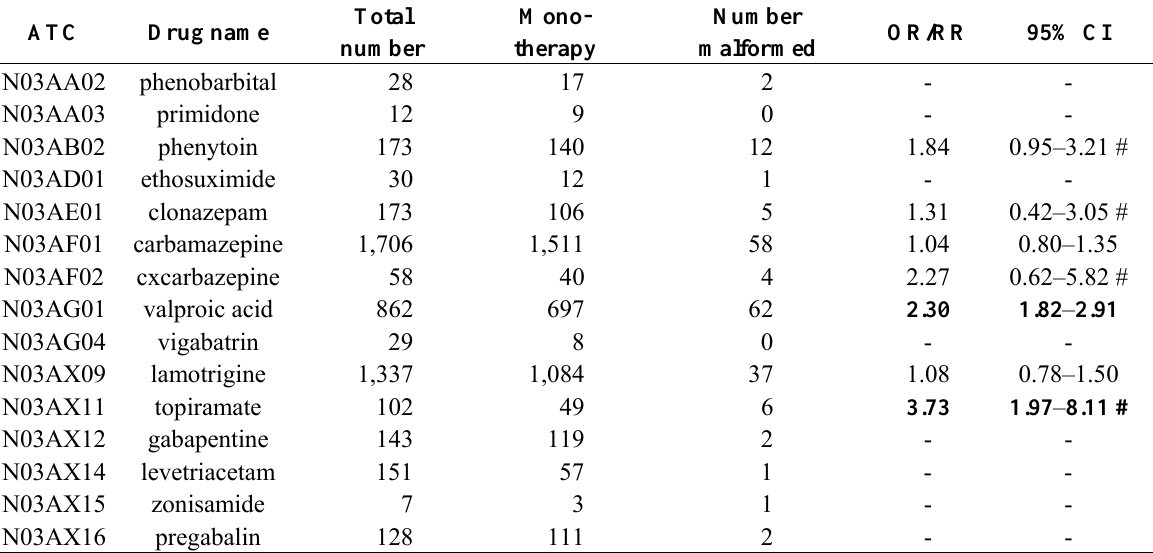
Table 13. Number of infants exposed in early pregnancy to various anticonvulsants, total and as monotherapy. Number with “relatively severe malformations” after monotherapy. Bold text marks statistical significance.